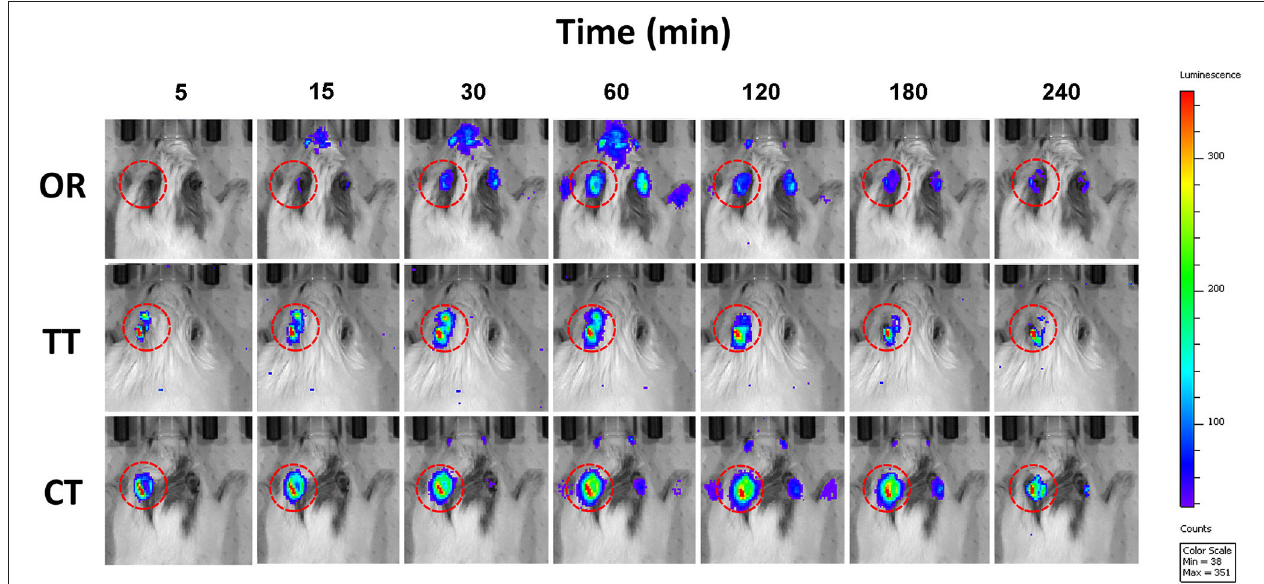
FIGURE 1 | Photon bioluminescence over time course in GFAP-Luc mice given luciferin. Time course showing photon bioluminescence in the inner ears of mice in oral administration (OR), transtympanic administration (TT), and combined therapy (CT) groups.